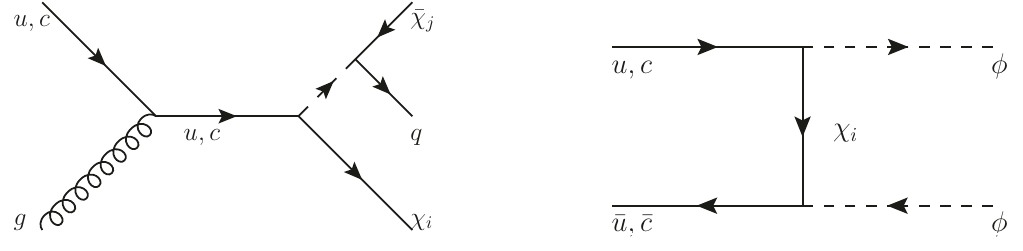
Figure 11 . Example Feynman diagram for the monojet (left) and dijet (right)